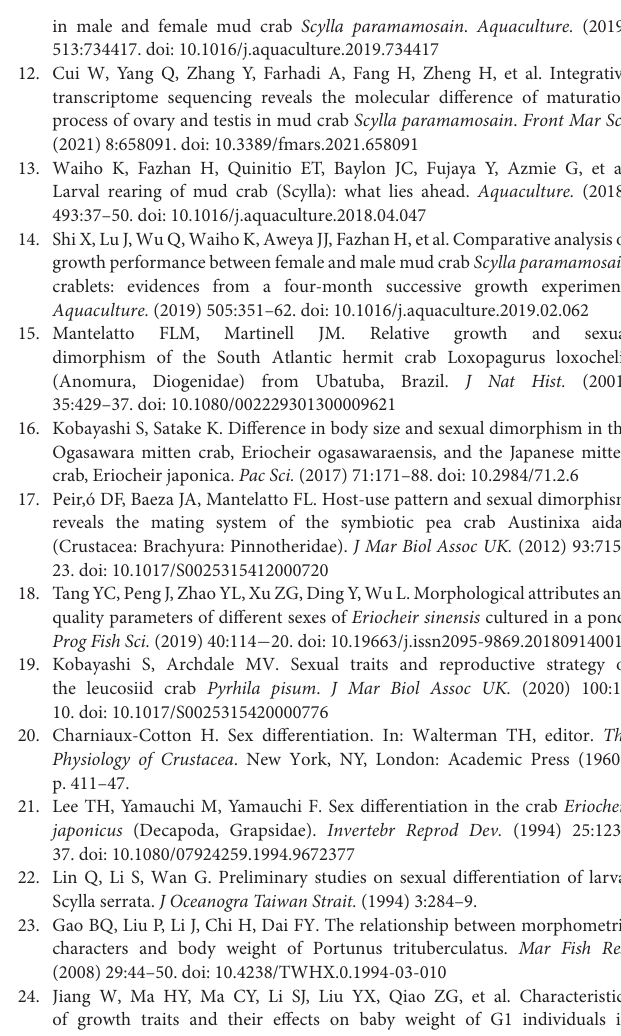
Supplementary Figure 1 | Genetic sex identification of some individuals at the different development stages of the S. paramamosain crablets. M, maker, C I, C II, C III, C IV, C V, C VI, C VII, and C VIII represent crablet of stage I, II, III, IV, V, VI, VII, and VIII. Supplementary Table 1 | Statistics of growth traits in different development stage of the juvenile S. paramamosain